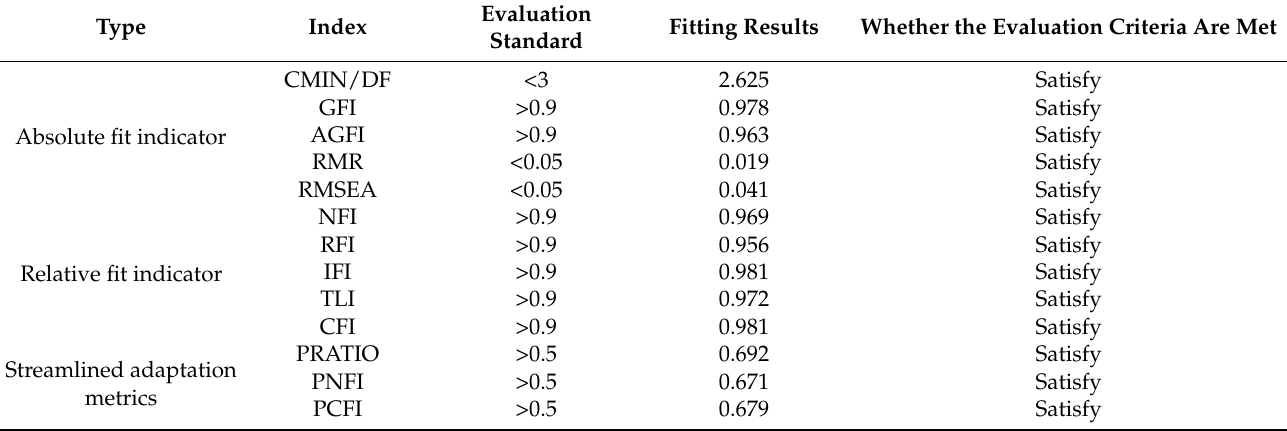
Table 4. Model overall fitness evaluation